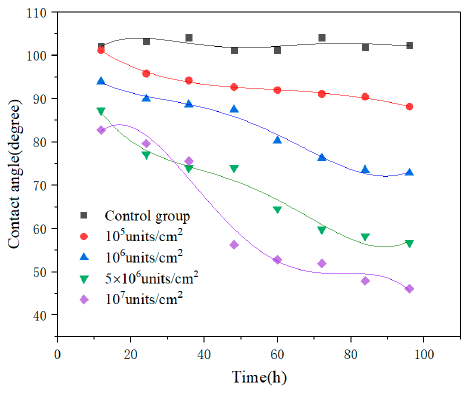
Figure 10. The contact angle of the RTV covered with different densities of algae.